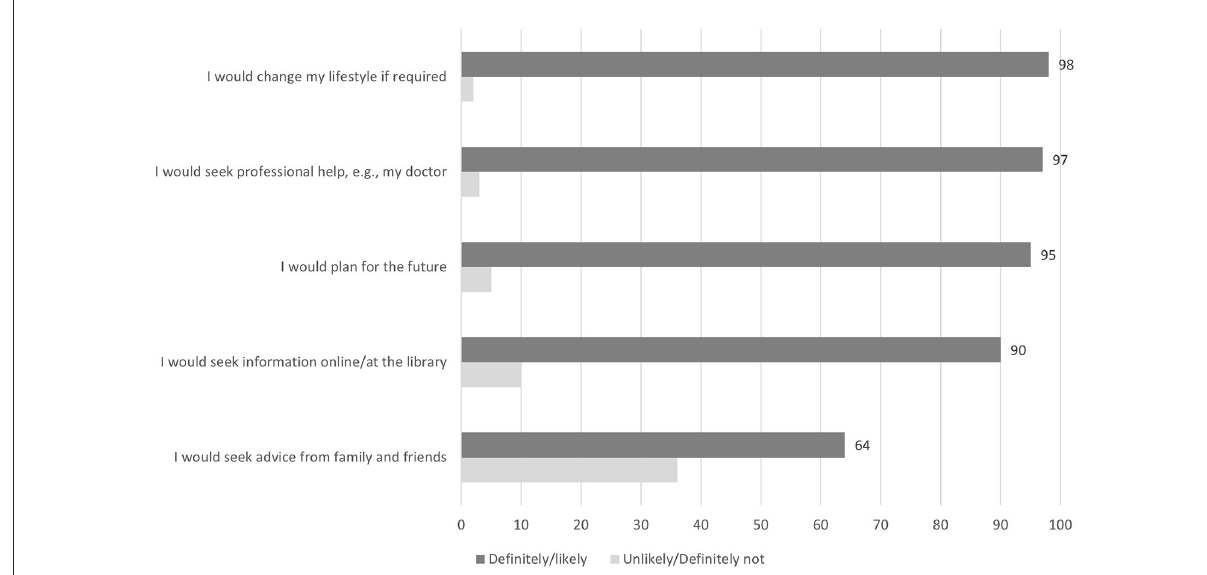
FIGURE4 Likely reactions to brain health test results. Numbers indicate the percentage of participants rating the given responses as positive (“Definitely yes” or “Fairly likely”) or negative (“Fairly unlikely” or “Definitely not”).